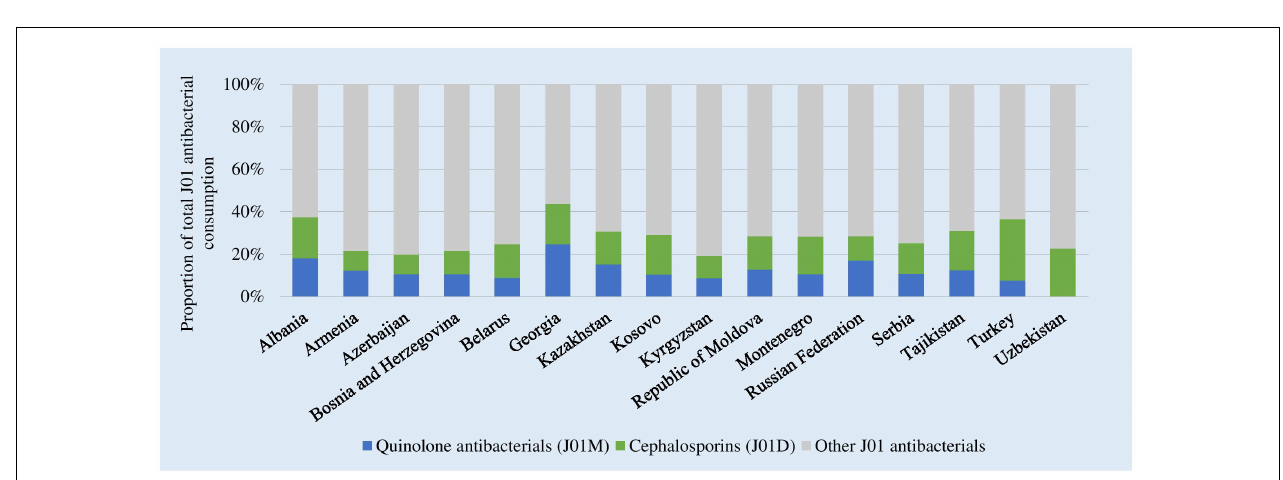
FIGURE 1 | Total consumption of J01 antibacterials by pharmacological subgroup in 15 countries and Kosovo, 2015. DDD, Defined Daily Dose; ∗ Kosovo [in accordance with United Nations Security Council resolution 1244 (1999)]; #Kazakhstan: commercial data source provides coverage of around 80–85% of hospital and community sales.